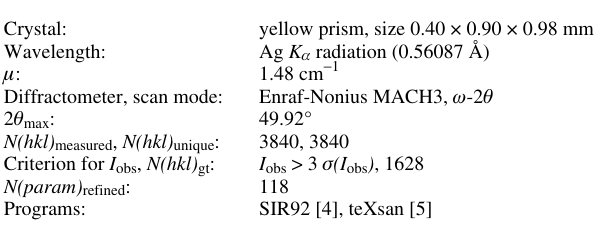
Table 1. Data collection and handling.